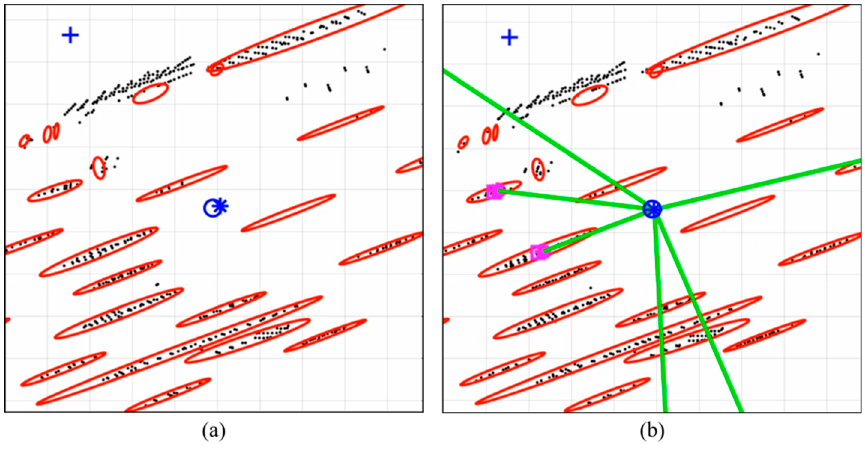
Figure 36. Comparison of Map Matching Result: ( a ) Scan Matching; ( b ) Scan Matching + Feature– Point Matching.